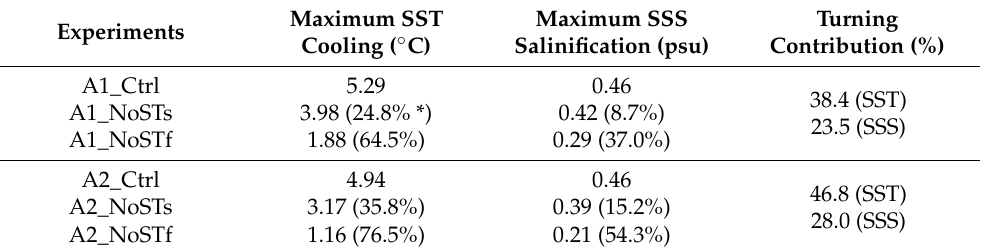
Figure 13. Temporal evolution of the temperature and salinity profiles in the 3DPWP experiments. ( a ) Temperature evolution in Experiment A2_Ctrl; ( b ) temperature evolution in Experiment A2_NoSTs; ( c ) temperature evolution in Experiment A2_NoSTf; ( d ) salinity evolution in Experiment A2_Ctrl; ( e ) salinity evolution in Experiment A2_NoSTs; and ( f ) salinity evolution in Experiment A2_NoSTf. The white solid lines represent the 20 °C isotherm. The white dotted lines represent the 18 °C isotherm. Table 2. Maximum SST cooling, maximum SSS salinification averaged within 100 km of the typhoon centre, and contributions of sudden turning to SST cooling and SSS salinification in each 3DPWP